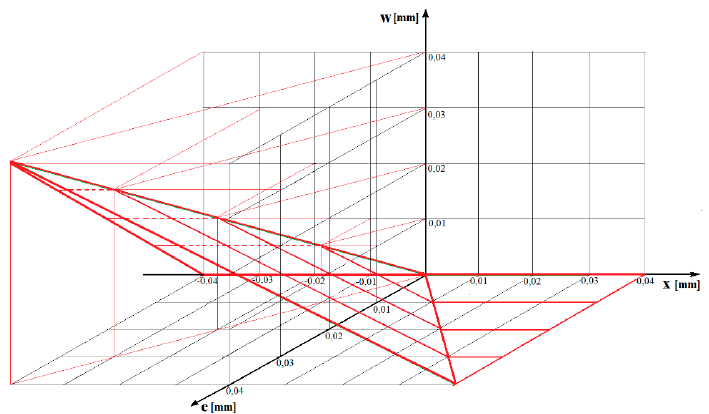
Figure 14. Graph showing the measurable value w of eccentricity e as a function of the vertical position x of the support.